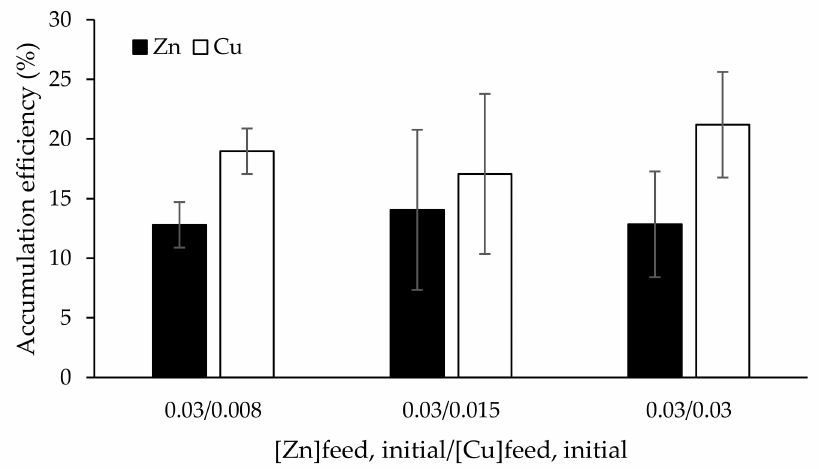
Figure 7. Effect of Cu presence on Zn accumulation. Feed phase: 100 mL of a 0.03 mM Zn and 0.008 to 0.03 mM of Cu in 0.01 M KNO 3 , pH 6.0; PIM: M2; receiving phase: 5 mL 0.01 M HNO 3 ( n = 3).